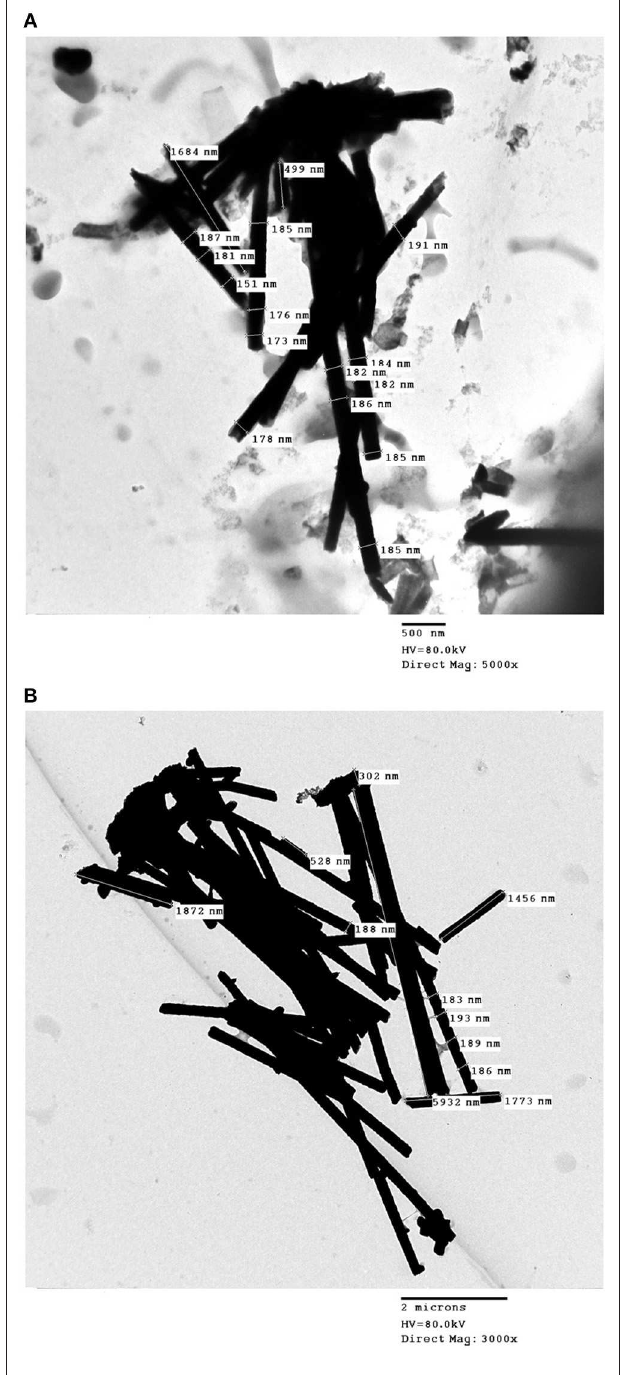
FIGURE 10 | TEM images of (A) Fe–Co–W and (B) Co–W nanowires. Fe–Co–W and Co–W nanowires were deposited under − 20.32mA (S = 2.54 cm2) and − 18mA (S = 2.25 cm2) pulse cathodic current density, respectively, with on– and off–time ton = toff = 0.1s.